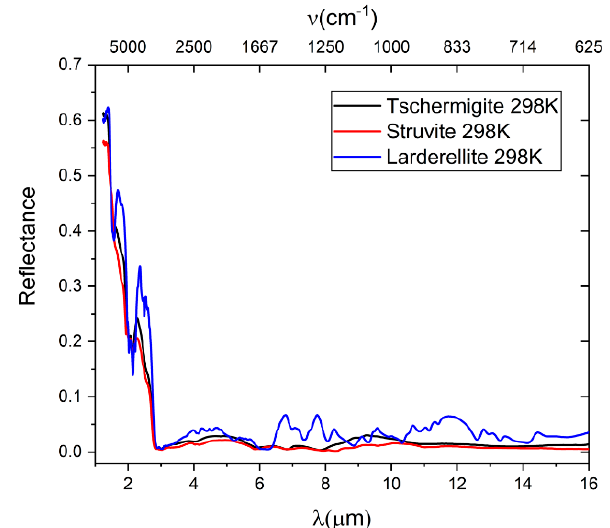
Figure 12. Comparison of part of the reflectance spectra of tschermigite, struvite and laderellite in the region of 1–16 μ m.